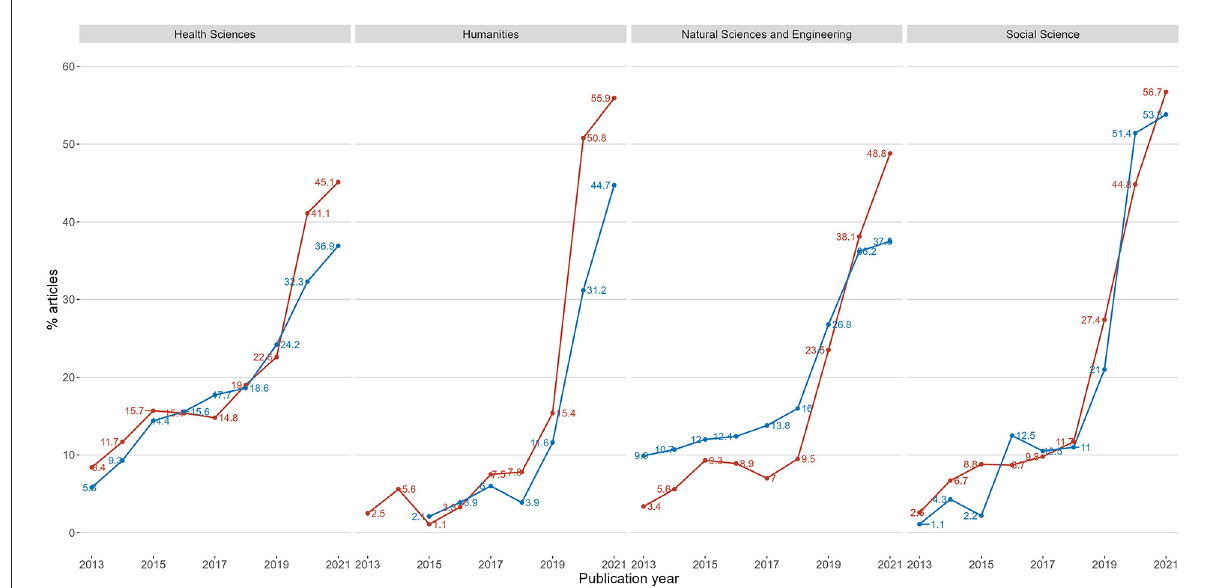
FIGURE11 Shares of hybrid open access articles on level high for two groups of disciplines. Blue line represents hybrid publishing on level high by disciplines with the option of gold open access journals on the high level, disciplines without this option is represented by the red line. The plot is separated on the four main research